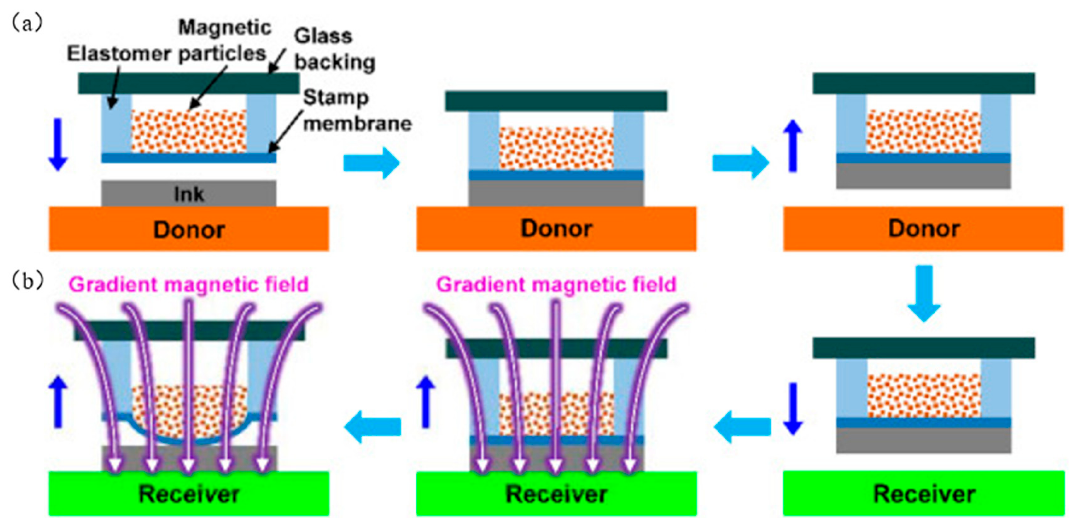
Figure 16. Diagram of magnetic controlled transfer printing technology (reproduced from [56]), ( a ) Represents the process of extracting ink from the source substrate by the magnetic seal, and ( b ) Represents the process of printing the magnetic seal on the target substrate.